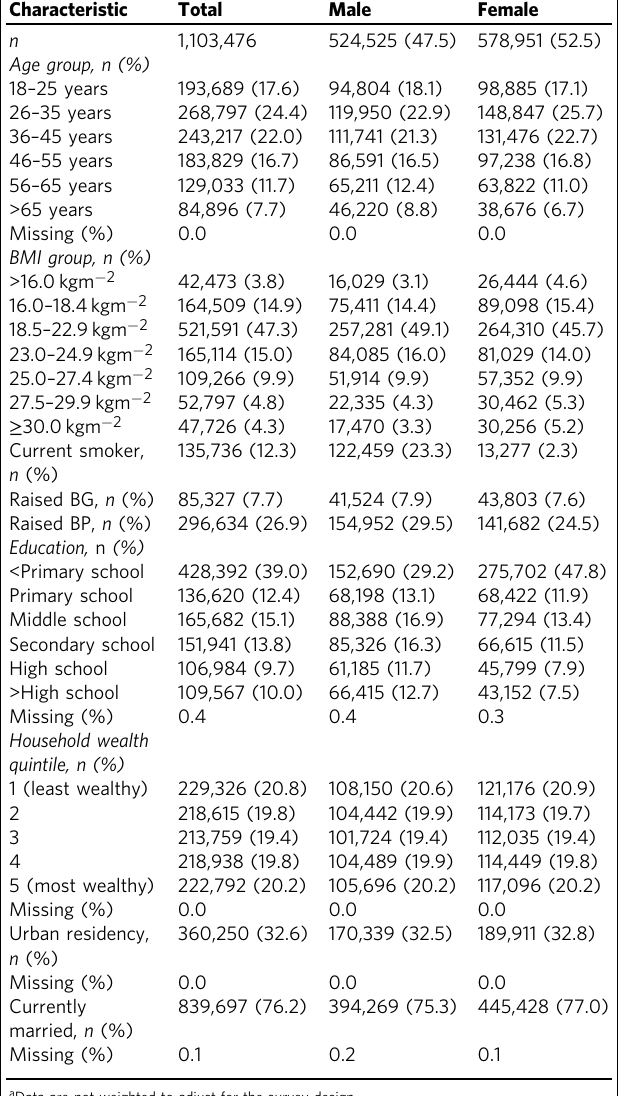
Table 1 Sample characteristics a,b